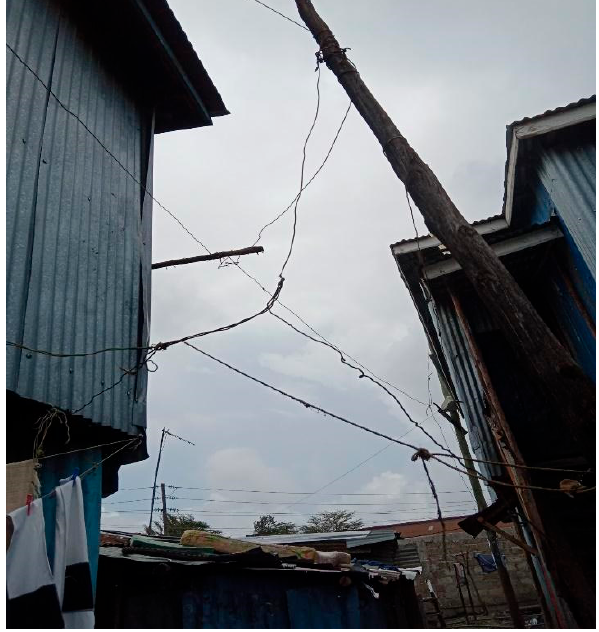
Figure 1. “So, the [electricity] wires are actually stima za kusambaza (illegal electricity connections), they are very dangerous. They can electrocute when wet . . . at night you cannot sleep because they start producing sparks . . . there is a time they burnt a house” (Daniel, 17-year-old boy, Viwandani).